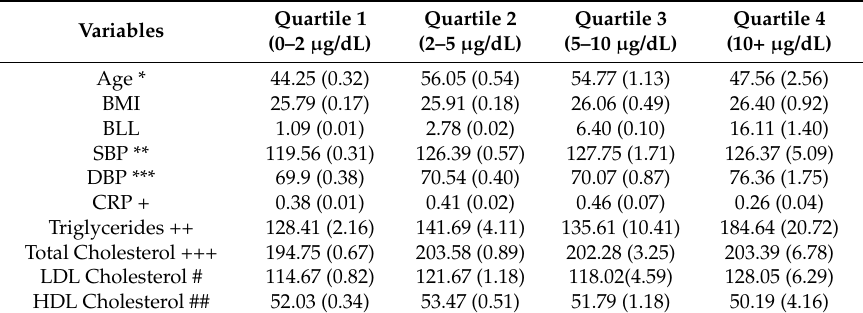
Table 1. Clinical Factors and Quartiles of